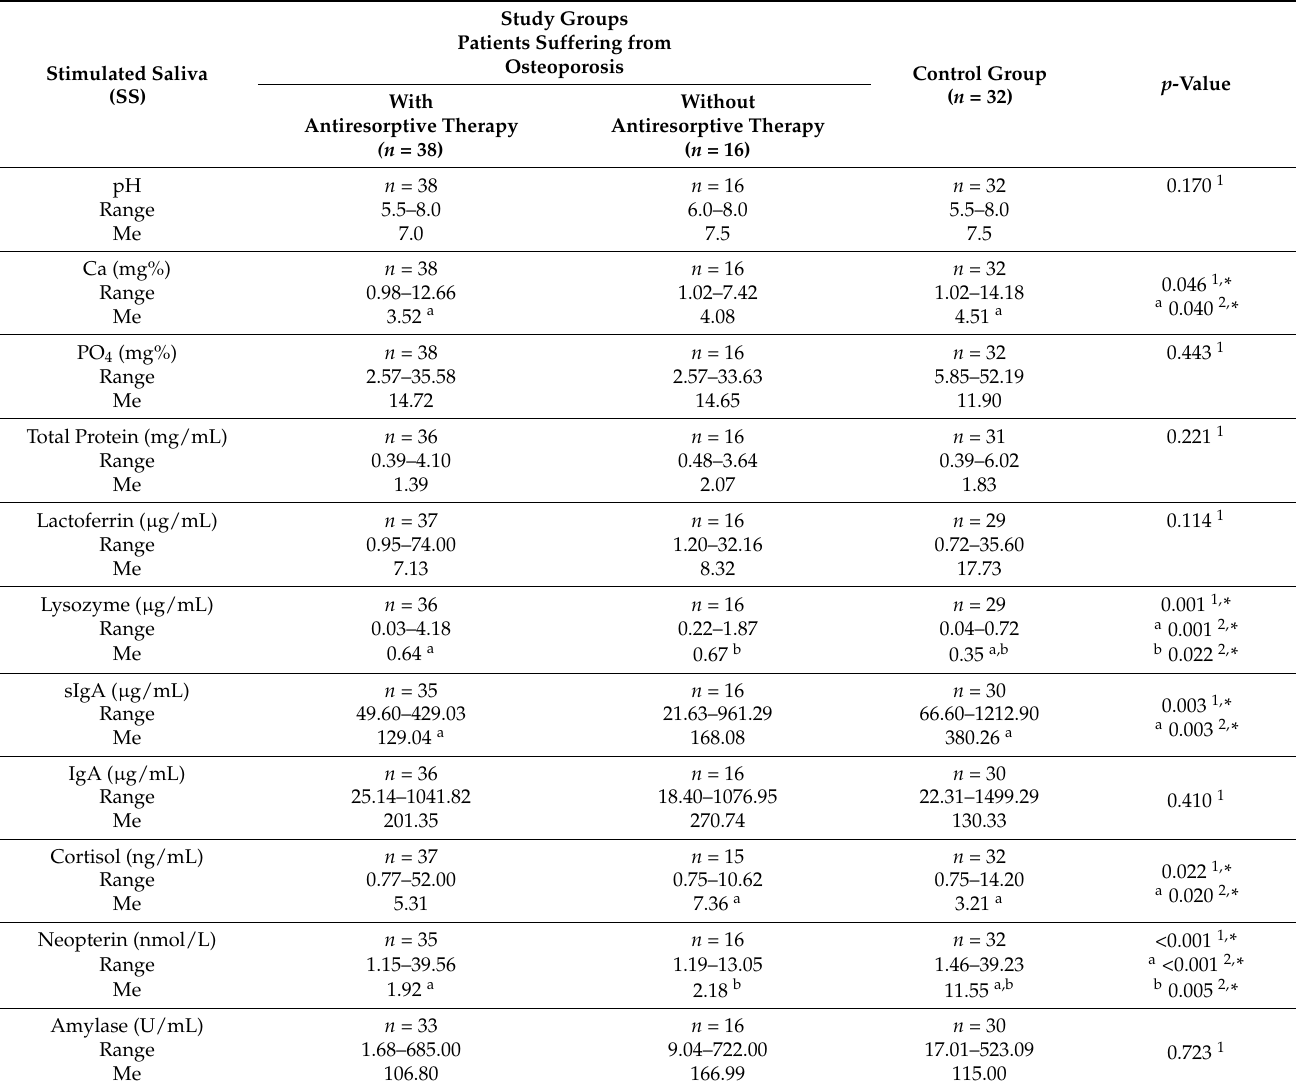
Table 2. Comparison of biochemical parameters in stimulated saliva from the study groups and the control group.